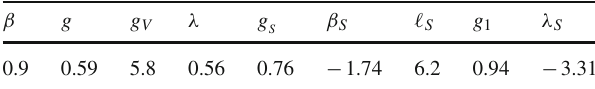
Table 1 The parameters and coupling constants adopted in our calcu- lation. The λ and λ S are in the unit of GeV − 1 . Others are in the unit